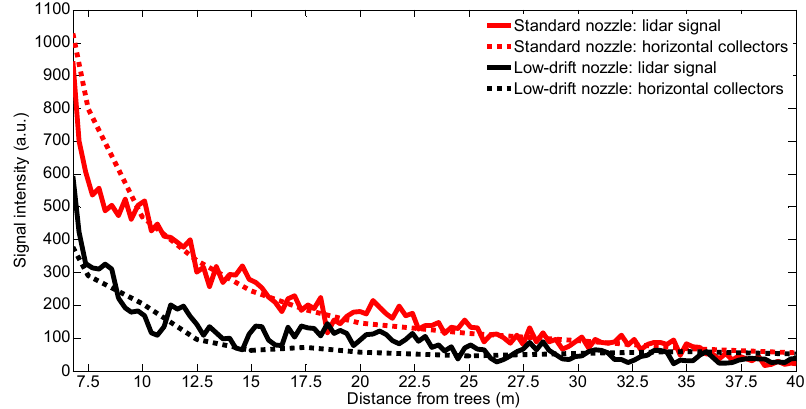
Figure 5. Tests T3 (low-drift nozzles) and T4 (standard nozzles). Time-integrated lidar signal and tracer mass captured by horizontal collectors at each downwind distance from the first tree row (arbitrary units).